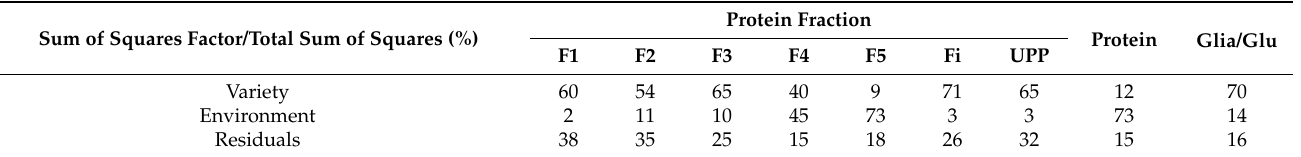
Table 3. Contribution (expressed in sum of squares values) of factors “variety” and “environment” to the variability of the studied